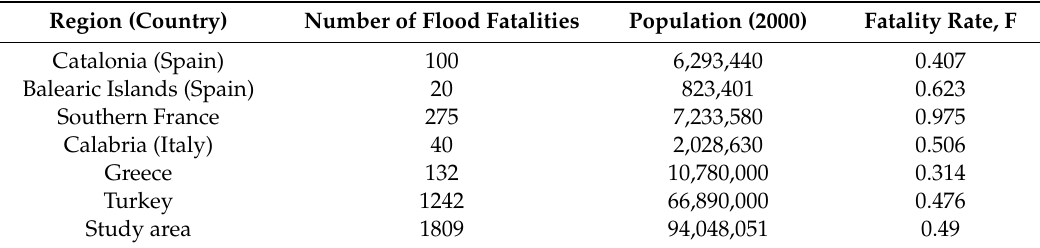
Table 2. Fatality rate (flood fatalities/year/1M inhabitants), F, per country (annual average for the period 1980–2018).